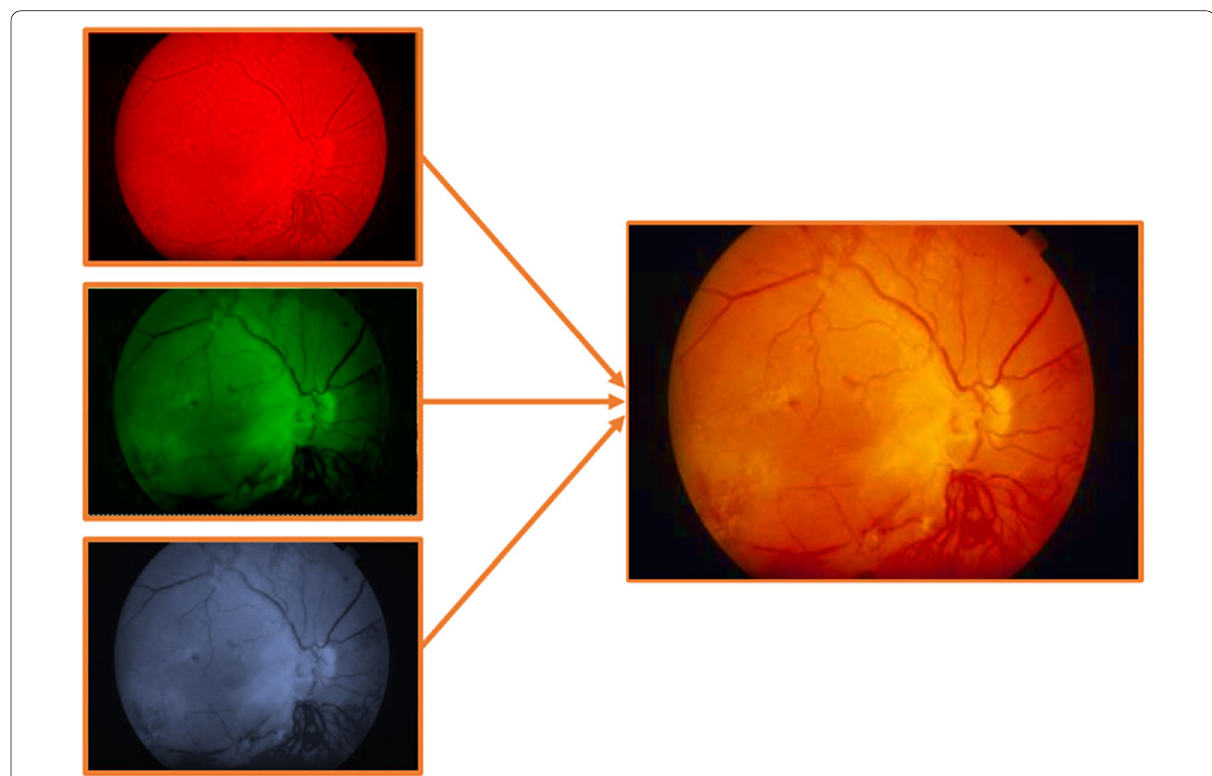
Fig. 3 The three color channels (red, green, blue) of a retina image for diabetic retinopathy detection